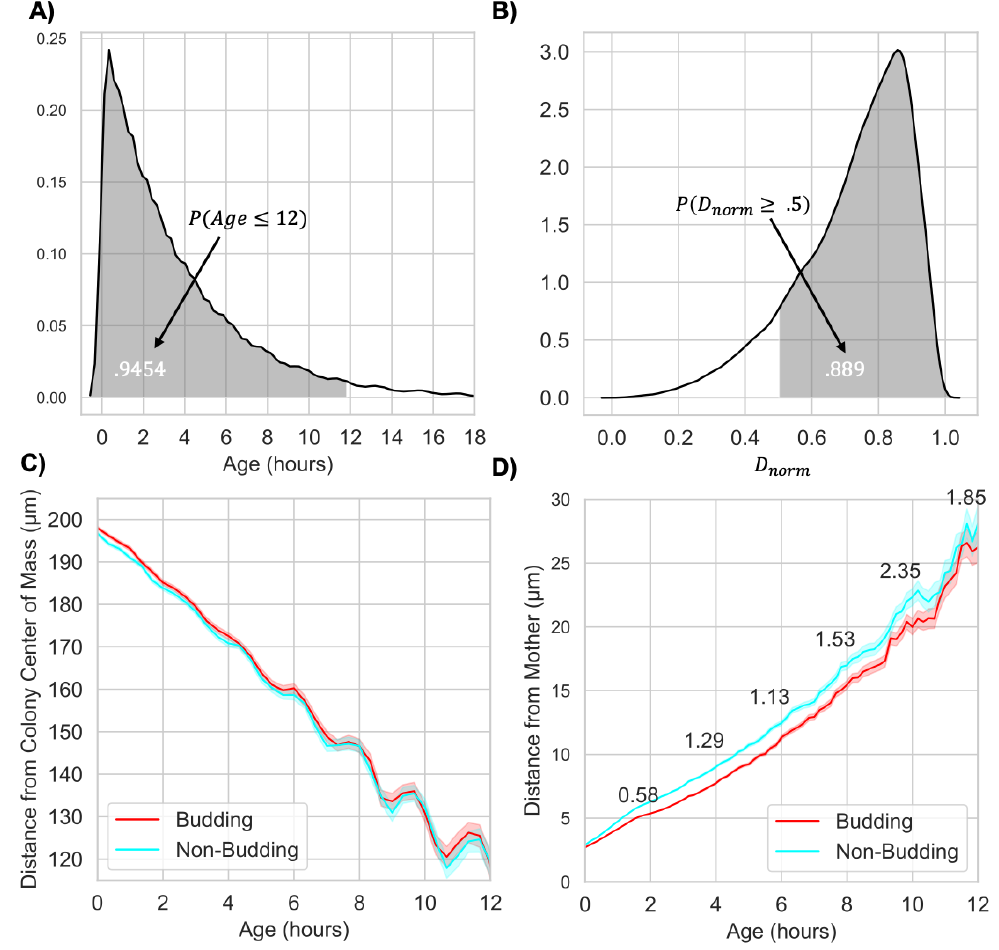
Figure 8. Age and Spatial Organization of Cells in Nutrient-Limited Colonies. ( A ) Empirical probability density function for cell ages in synthetic colonies after 28 h of colony growth. We observe that the probability that a given cell is ≤ 12 h old is 0.9454; ( B ) Empirical probability density function for the normalized distance from the colony center of mass to the birth location of cells born in the last hour of colony growth ( D norm ). We observe that the probability that D norm is ≥ 0.5 is 0.889; ( C ) Cell age (h) versus cell distance from the colony center of mass for budding (red) and non-budding (blue) colonies at the 28 h time point. In both ( C , D ) average values were determined for different age groups using a sliding window with a fixed window size of 20 min. We conclude that distance from the colony center of mass at 28 h is strongly correlated with age. However, we see that cell distance from the colony center of mass is not impacted by budding division since 95% confidence intervals overlap; ( D ) Cell age (h) versus cell distance from its mother for budding (red) and non-budding (blue)